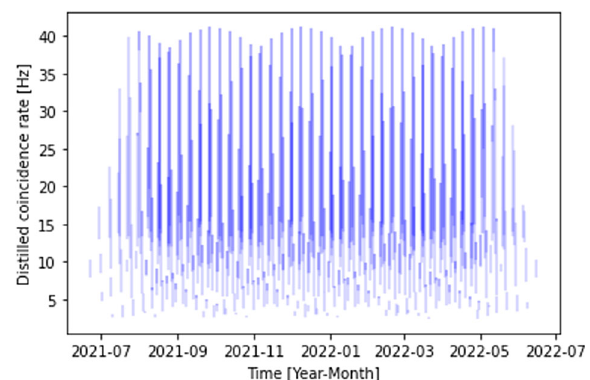
Fig. 6 Average raw coincidences per day as reported in Table 3. Shown are results for a LEO with inclination 50 degrees and height 600 km and a MEO with inclination 60 degrees and height 8000 km, and for wavelengths of 810 and 1550 nm with avalanche photo detectors (Si-APD @ 810 nm, InGaAs-APD @ 1550 nm; green bars) and super-conducting nanowire single photon detectors (blue bars).